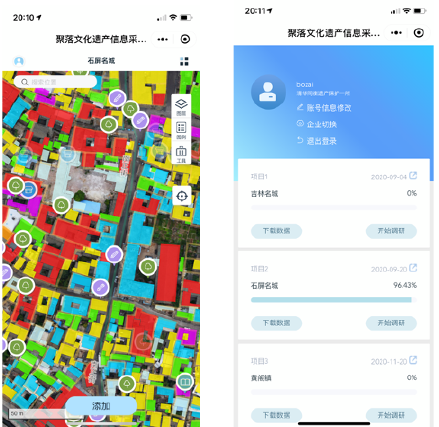
Figure 2 . WeChat Mini-Program Front-end (Data Collection Interface on Left; Project-orientation Interface on Right), Example of Shiping Historic City.